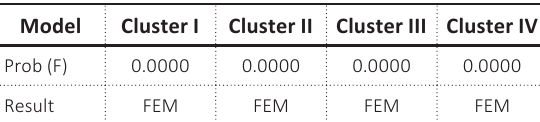
Table 3. The Wald test on the panel regression model